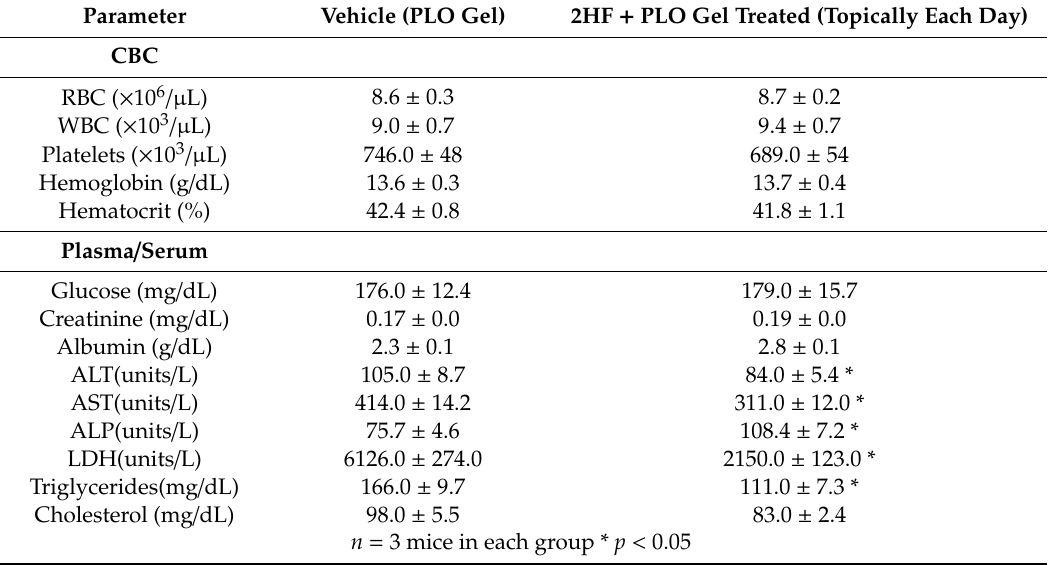
Table 2. E ff ect of 2HF (12 mg / 0.1 mL PLO gel) on blood counts and serum chemistry